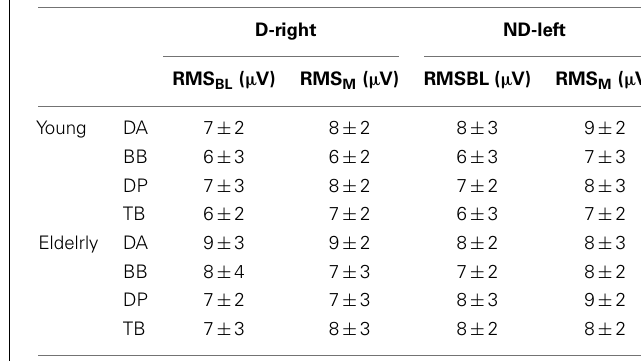
Table 1 | Root mean square (RMS) average values ( ± SD) from arm muscles during mental movements involving the dominant-right arm (D-right) and the non-dominant-left arm